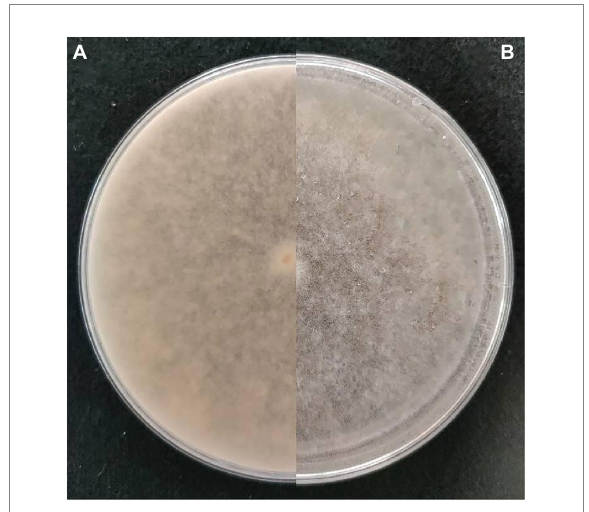
FIGURE 1 Morphological characteristics of colony of Rhizopus oryzae Y5. (A,B) . Colony on PDA after 5 days’ incubation at 25 ° C in the dark (front and